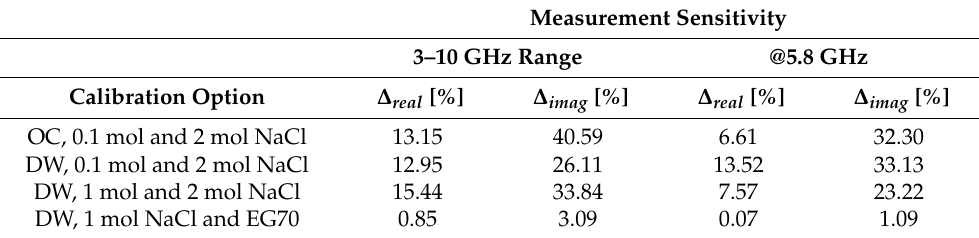
Figure 10. S&S de-embedding with the 4th calibration option: DW, 1 mol NaCl and EG70 (smoothing applied): ( a ) Calculated vs. reference ε ’; ( b ) calculated vs. reference ε ’’; ( c ) sensitivity (de-embedding error) for ε ’ (“real”) and ε ’’ (“imag”). Table 3. Averaged sensitivity in the 3–10 GHz range and at 5.8 GHz for S&S de-embedding with different calibration options.